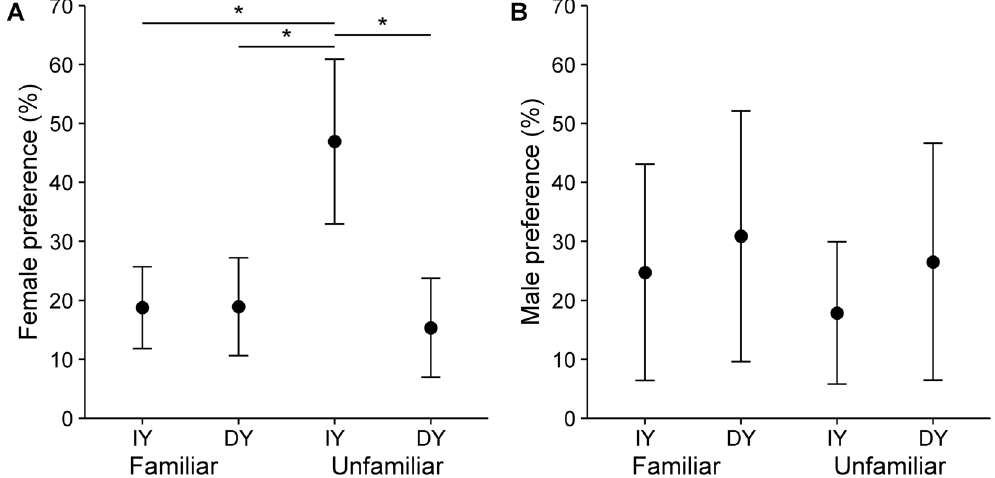
Figure 1. Results of mate choice experiments on white-eyed bulbuls ( Pycnonotus xanthopygos ) using four stimuli with increased or decreased yellow ventral plumage colour (IY: Increased yellow, ID: Decreased yellow) and familiarity. Means presented as dots with 95% CL. Significant differences are marked with an asterisk (Tukey’s post hoc test). ( A ) female mate choice ( B ) male mate choice.